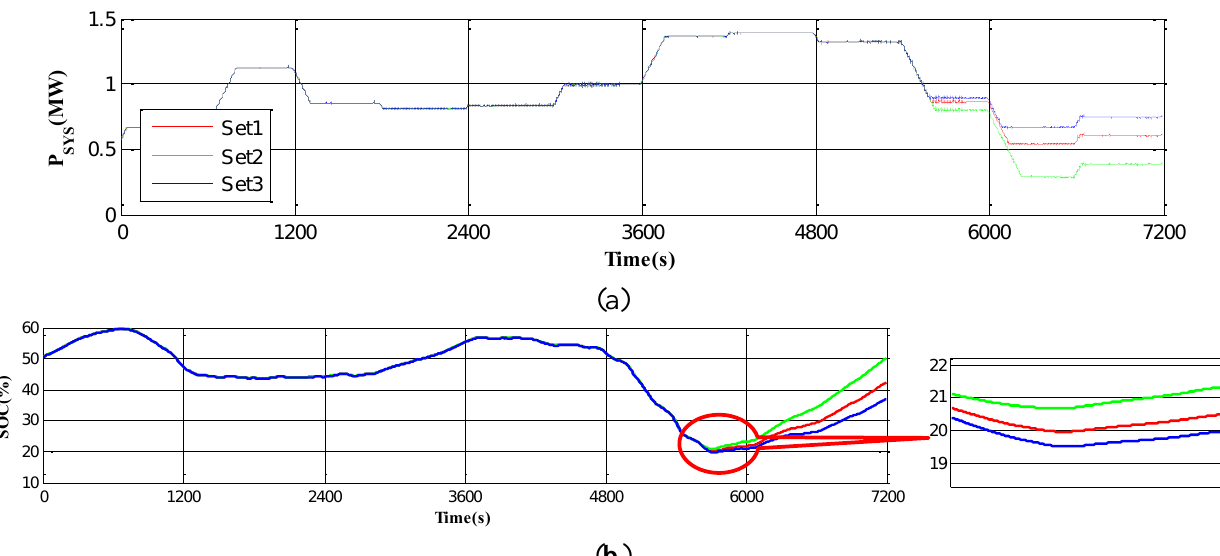
Figure 15. Simulation results for Case 4 with different tuning constant sets: ( a ) total system power output; and ( b ) SOC level of